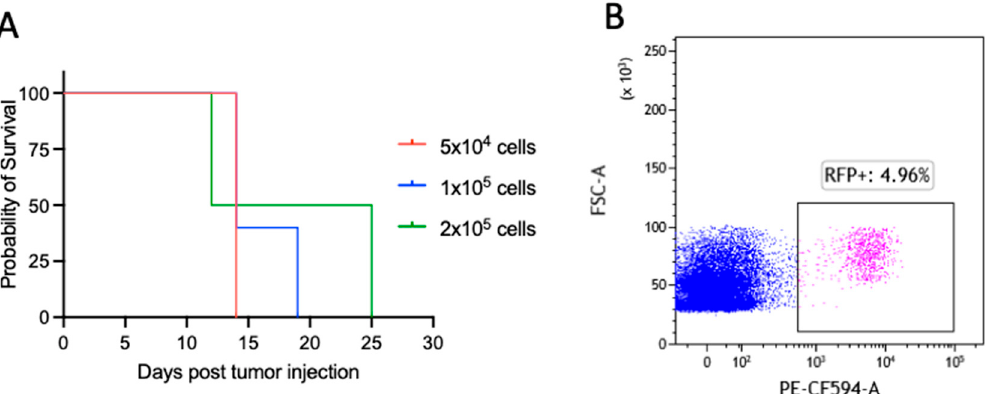
Figure 1. Ly27085-Luc is a lymphoma model with high penetrance and low latency. ( A ) Kaplan-Meier survival analysis of mice injected intravenously with 5 × 10 4 (red line), 1 × 10 5 (blue line), and 2 × 10 5 (green line) Ly27805-Luc cells. The Mantel-Cox test was performed to assess statistical differences in survival between the three groups (n = 5 per experimental condition). ( B ) Representative flow cytometry plots showing percentage of RFP + cells within the spleen of a control mouse. Cells were gated according to physical parameters.